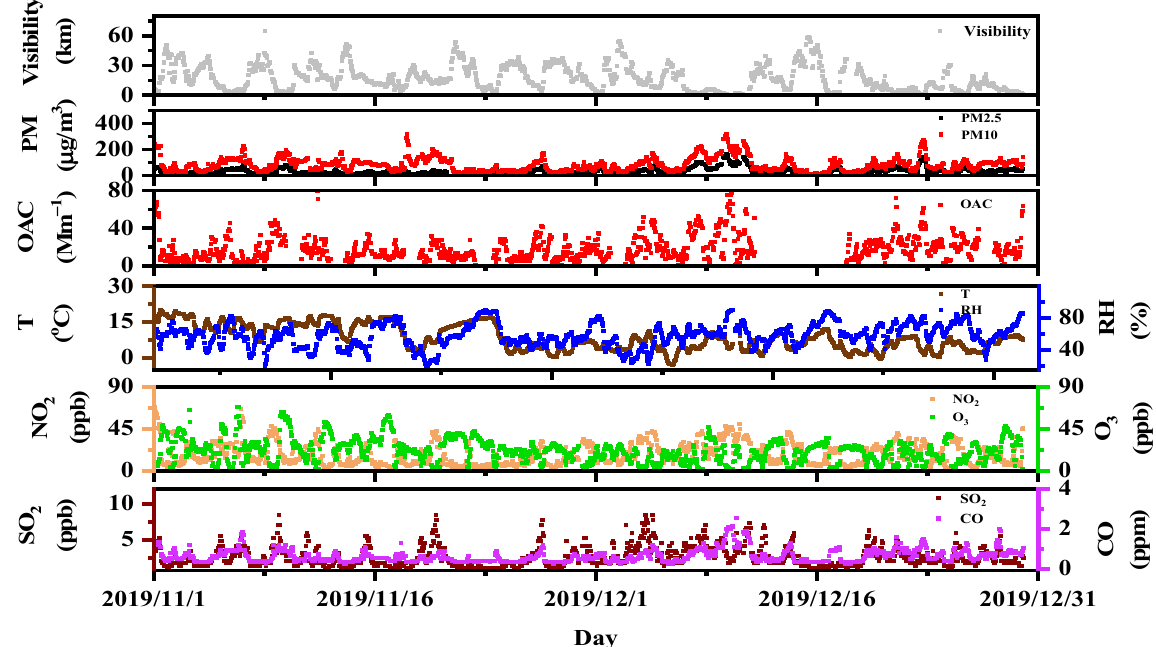
Figure 2. Time series of optical properties, air pollutant concentrations, and meteorological data.